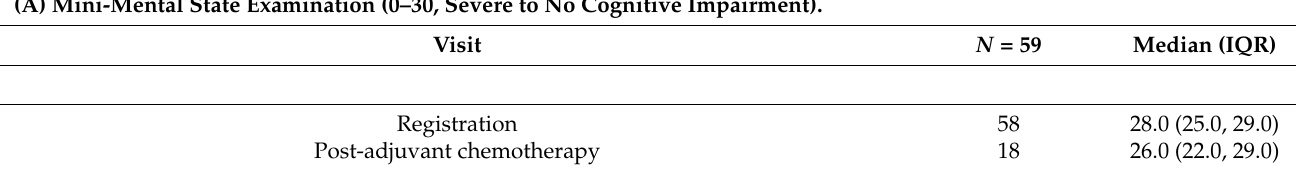
Change from registration to post-adjuvant chemotherapy (B) NIH Stroke Scale (0–42, No to Severe